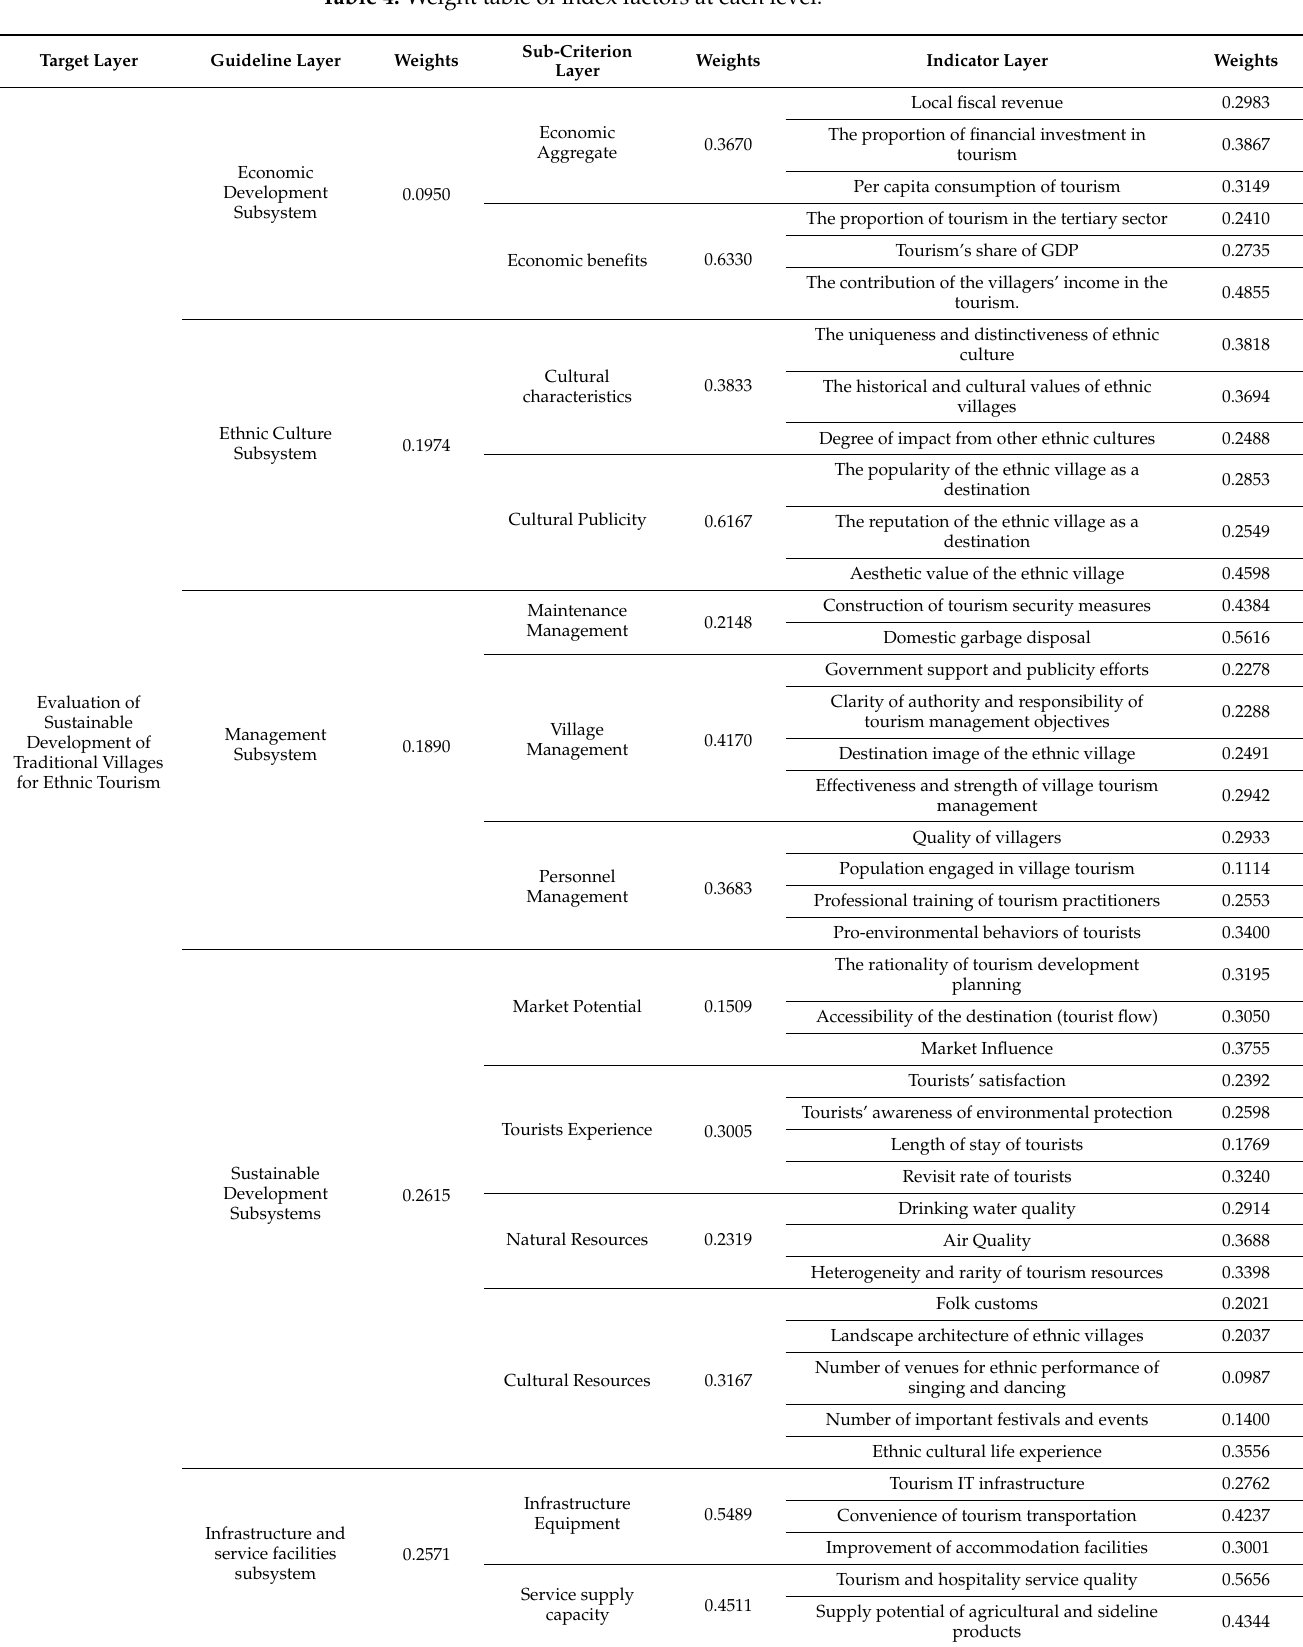
Table 4. Weight table of index factors at each